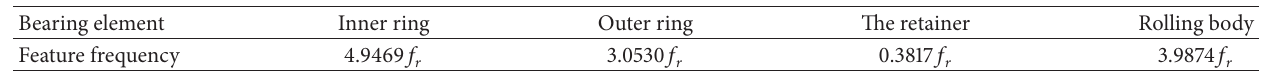
Table 4: Rolling bearing fault feature frequency of SKF6203.